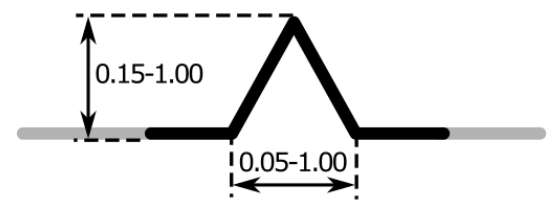
Figure 6. Visualisation of the polyline in the cell of the survey card. Magnification (10 × ) of the cell in row 18 and column 20; dimensions are given for all cells.